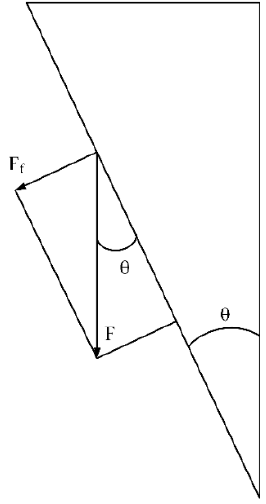
Figure 5. Force status of the cutter.